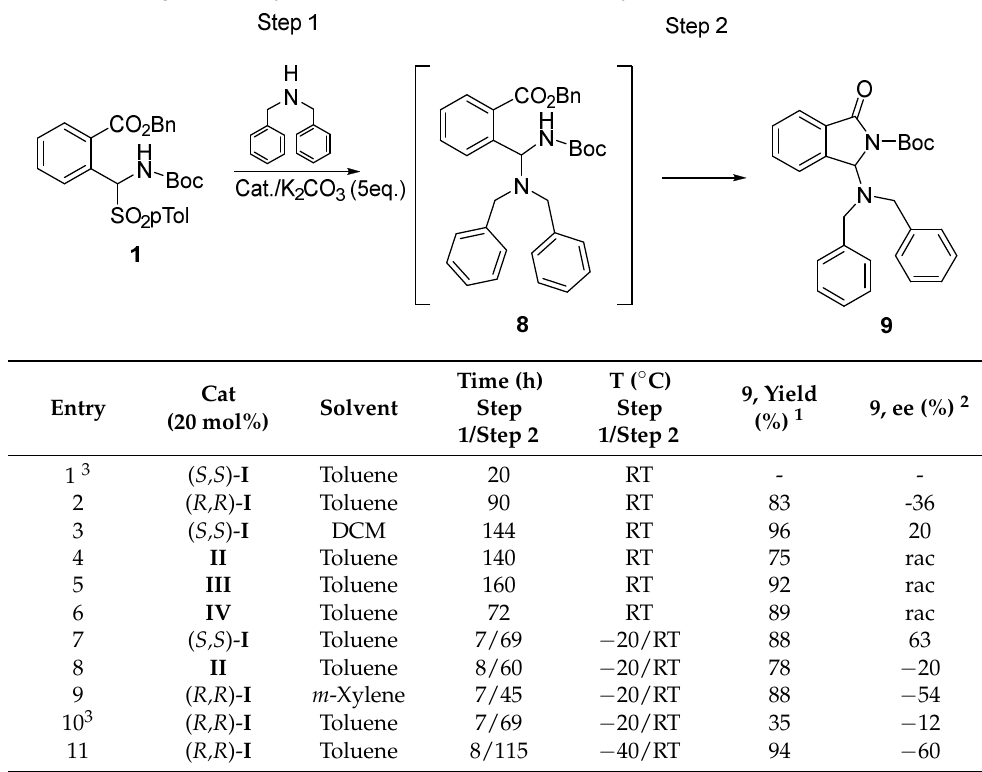
Table 4. Investigation of asymmetric reaction of 1 with dibenzylamine.